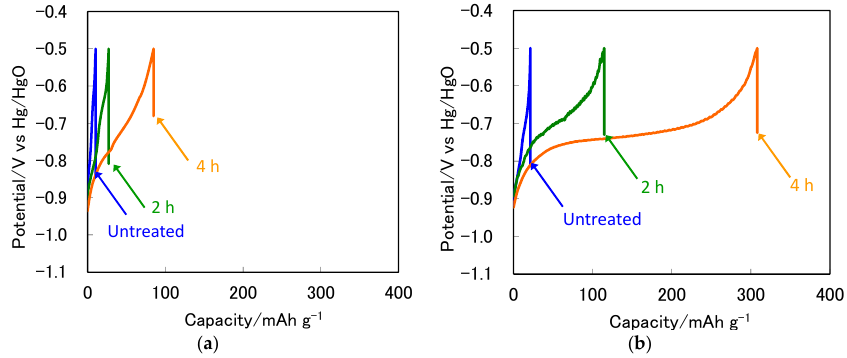
Figure 1. Discharge curves for the ZrNi electrode with and without the boiling alkaline treatment for 2 h and 4 h at ( a ) 303 K and ( b ) 333 K.